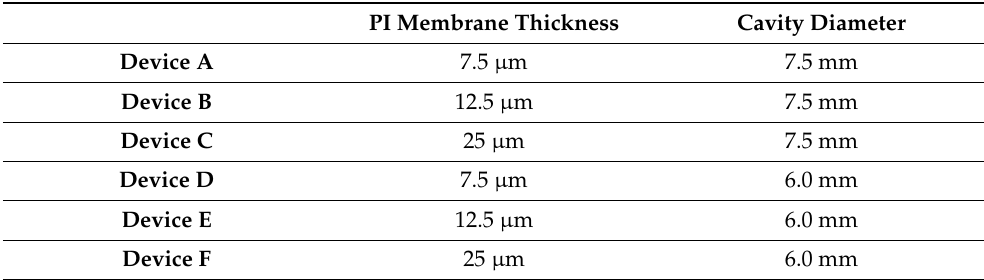
Table 1. Dimensions of the fabricated